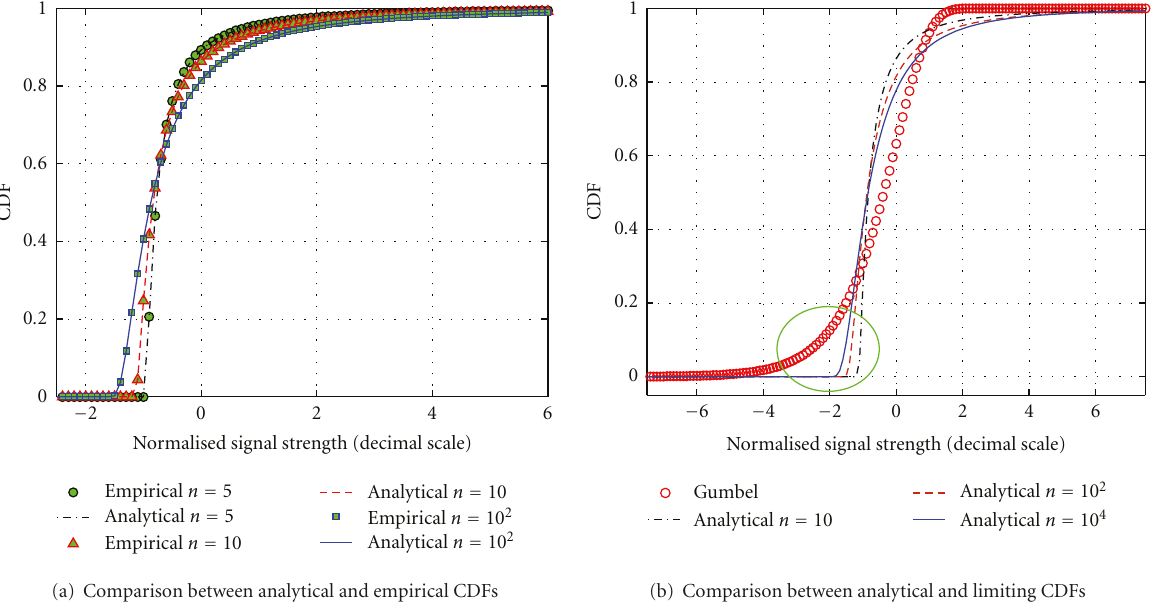
Figure 1: CDF of " M n under di ff erent n : σ dB = 8, β = 3.